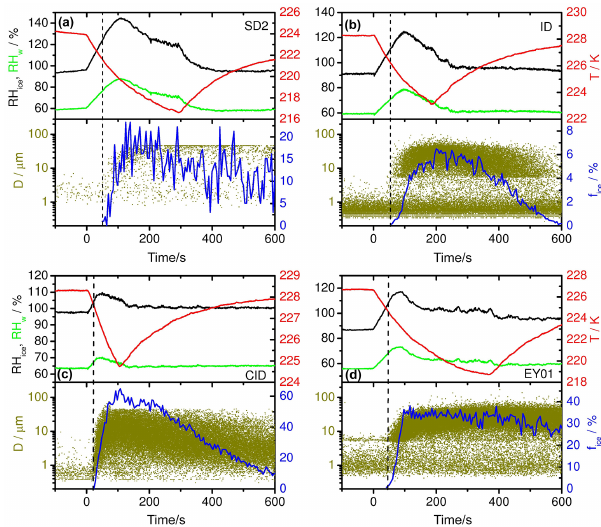
Figure E1. Comparison of the ice nucleation characteristics of un- processed SD2 (a) , ID (b) , CID (c) , and EY01 (d) particles during expansion cooling at temperatures below 237K. The data types are the same as shown in Fig. 3. In the experiment with the SD2 parti- cles, only the optical particle counter with the upper size threshold of 46µm was operated. This means that larger ice crystals were still appropriately counted but not correctly sized (i.e. classified to the size channel 46µm).